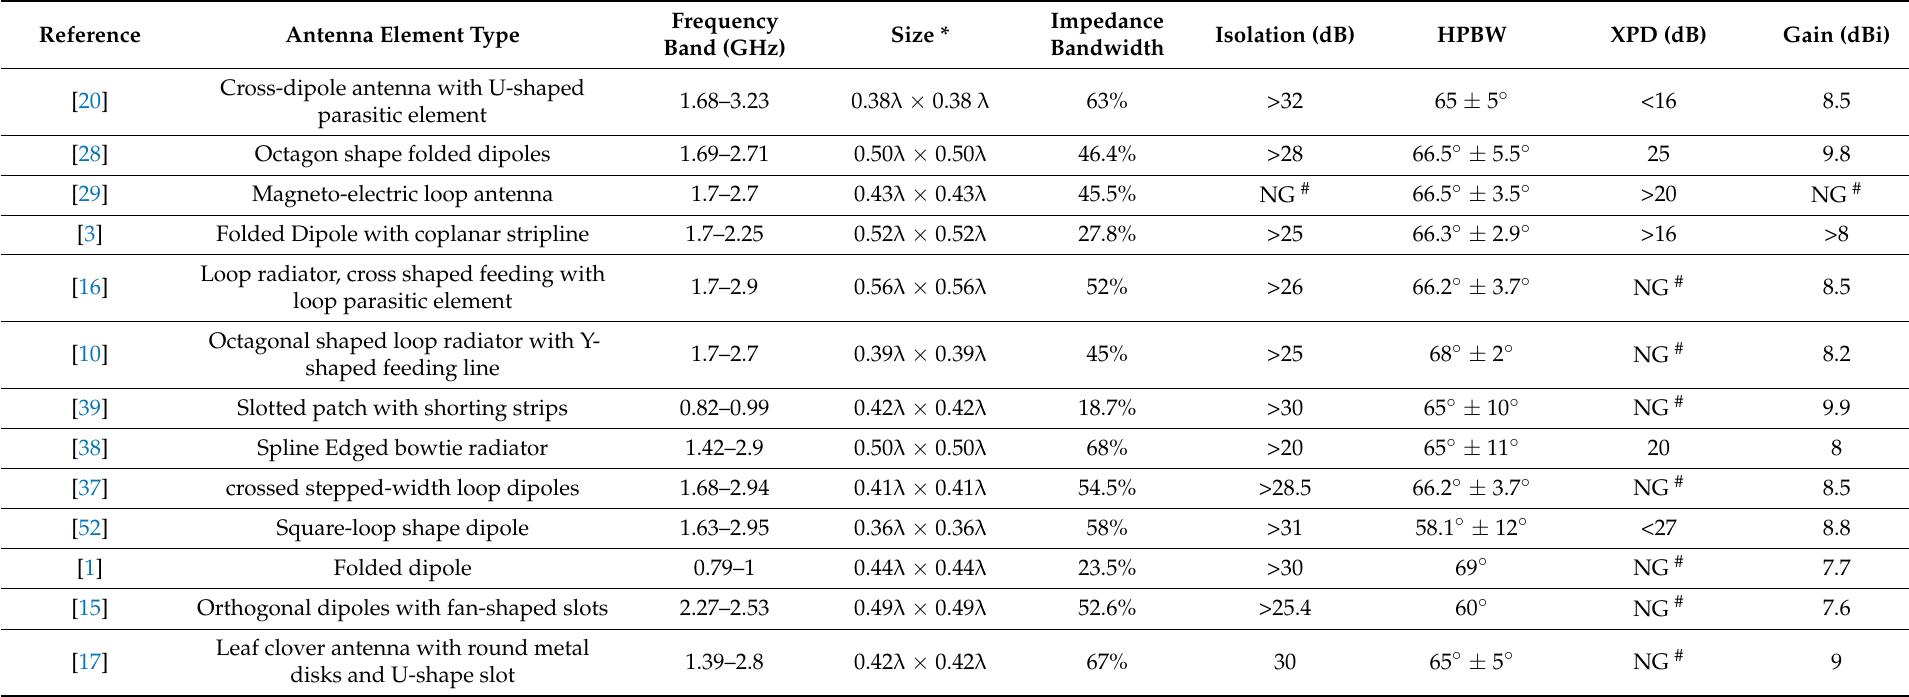
Table 4. Comparison of a selected set of wideband radiating elements used in